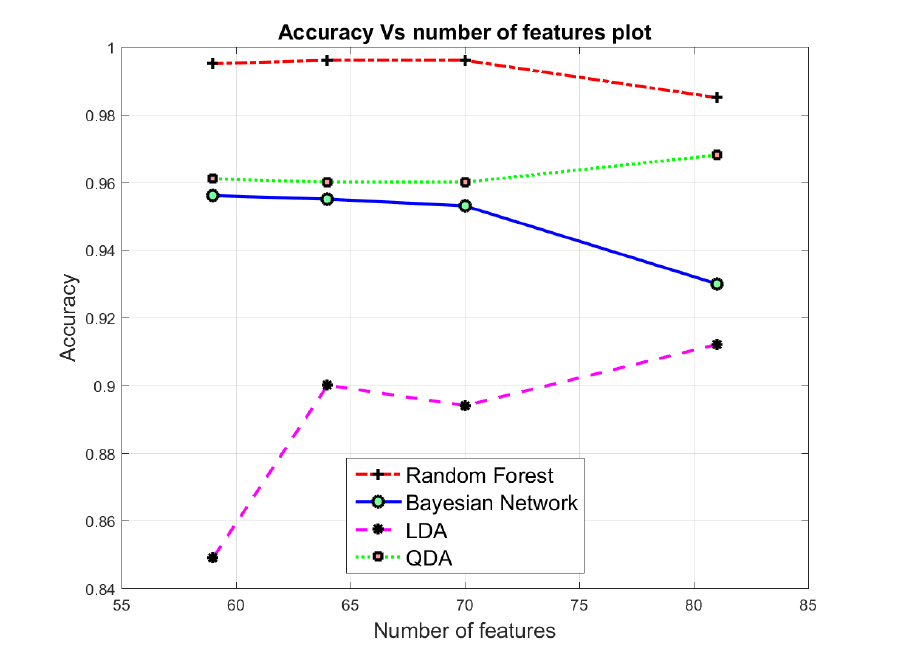
Figure 6. Multi Class Classification: Accuracy in terms of number of features using